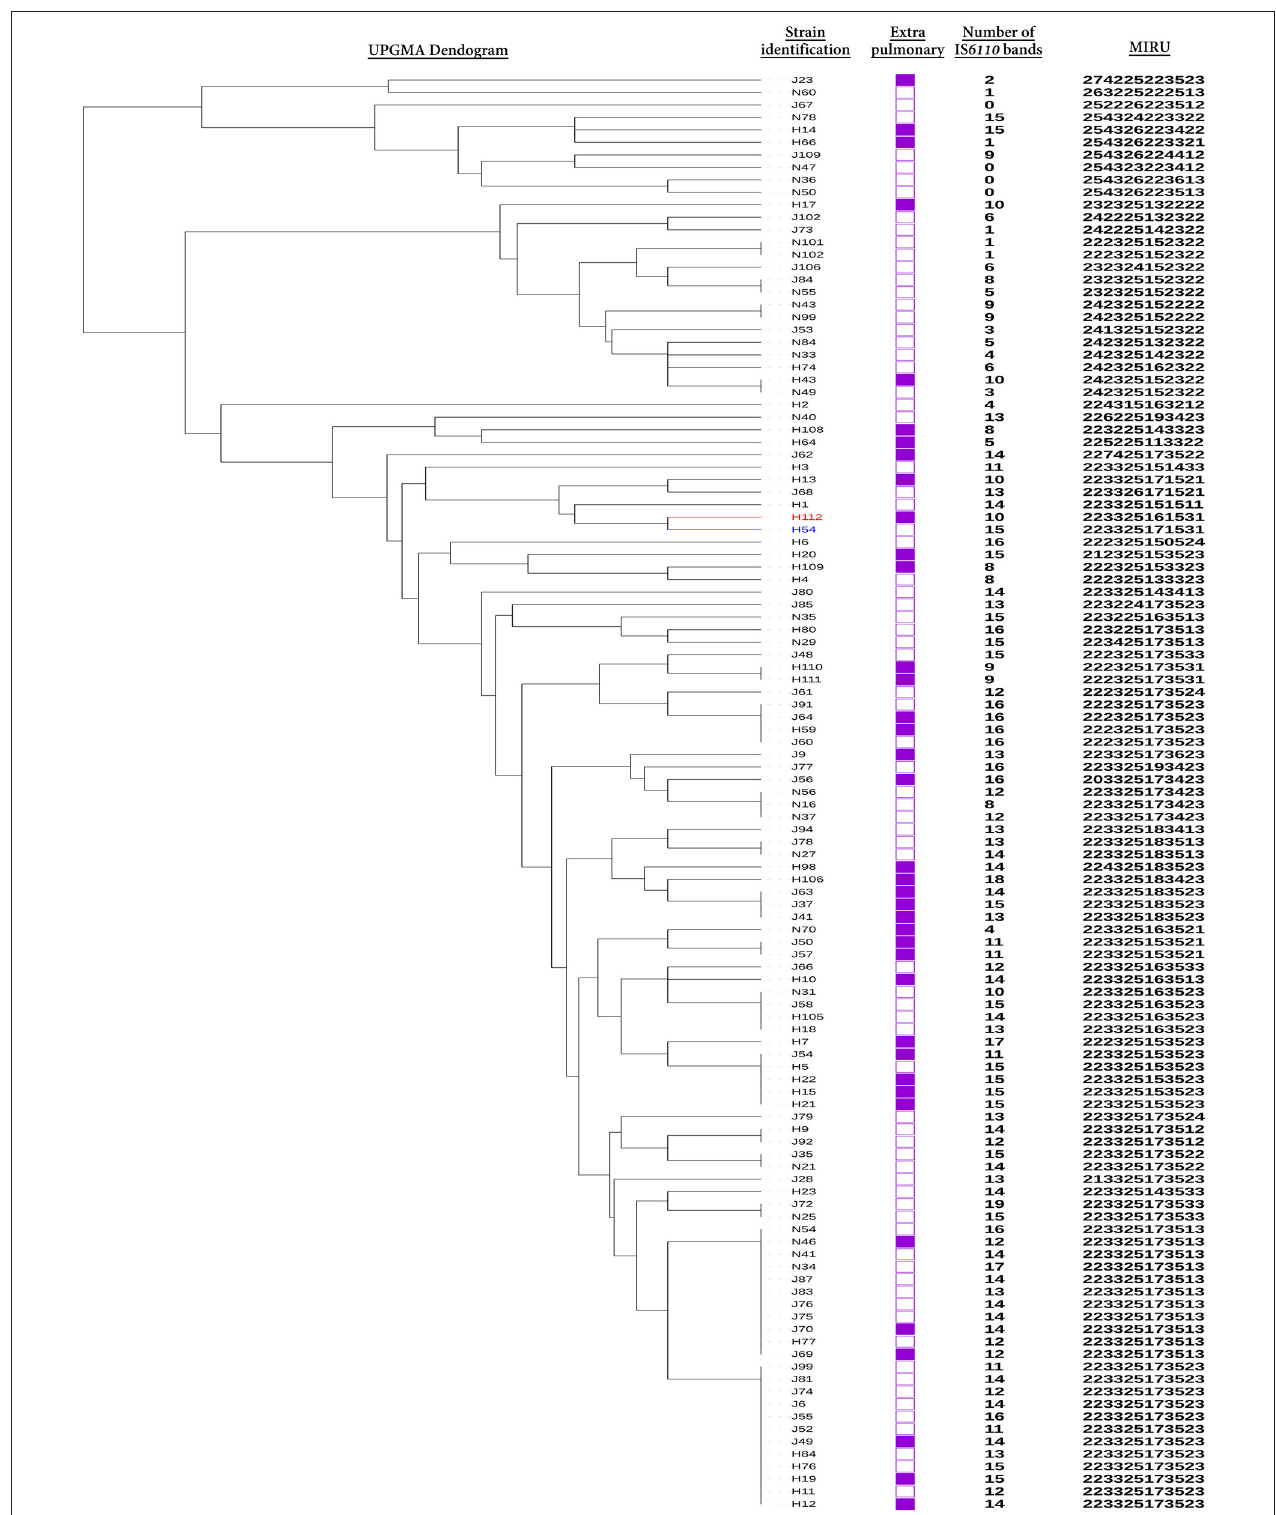
FIGURE 1 | Selection of control strain. The relationship between Hypervirulent strain H112 (Red), control strain H54 (blue), and other 113 strains is indicated via dendogram. The dendogram was constructed using unweighted pair group method with arithmetic mean (UPGMA) algorithm based on MIRU. Additional information related to source of all strains that is extra-pulmonary (filled squares) or pulmonary TB (empty squares), number of IS6110 -RFLP bands and MIRU patterns are also illustrated.